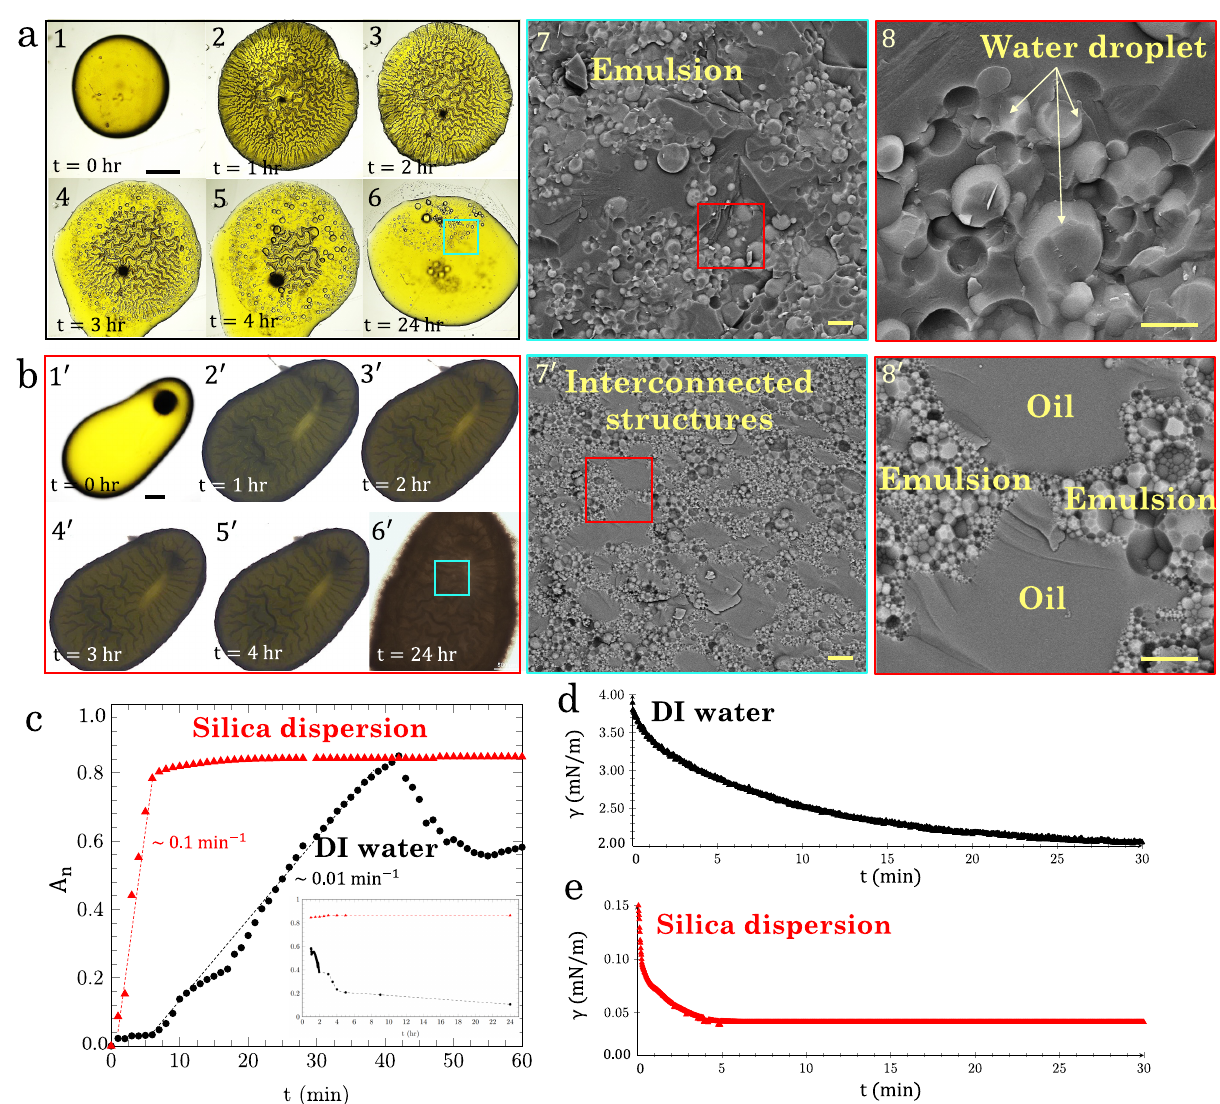
Fig. 2 Spontaneous formation of interfacial materials. Bottom view images of the changes over time for a a DI water droplet and b 4.0 wt.% silica dispersion droplet in 20.0 wt.% Span micellar solution (scale bars = 500 μ m). Cryo-SEM images of the interfacial materials generated from DI water and a 4.0 wt.% silica nanoparticle dispersion after 24 hours are shown in ( a , 7 – 8) and ( b , 7 ′ – 8 ′ ). In the sample generated from DI water ( a , 7 ′ – 8 ′ ), an emulsion zone containing submicrometer water droplets is formed. In the sample formed from the silica dispersion ( b , 7 – 8), interconnected structures of oil and emulsion phases are formed uniformly throughout the sample. In the cryo-SEM images, the dark and light gray colors represent, respectively, oil and aqueous phases, while the nanoparticles are not visible. The scale bar in ( b , 7 and 7 ′ ) is 10 μ m and in ( b , 8 and 8 ′ ) is 5 μ m. c Rate of emulsion phase formation. The surface area covered by emulsions divided by the total surface area of the droplet is de fi ned as A n and plotted over 60 min. The data points of the DI water droplet and 4.0 wt.% silica dispersion droplet are shown in black and red, respectively. The slope of initial regime in each case represents the rate of emulsion phase formation. The inset of the fi gure shows A n over 24 h. Dynamic interfacial tension ( γ ) of d DI water-20.0 wt.% Span micellar solution and e 4.0 wt.% silica dispersion-20.0 wt.% Span micellar solution. γ of DI water decreases slowly over time while γ of the silica dispersion remains constant after 2 min. Source data are provided as a Source Data fi